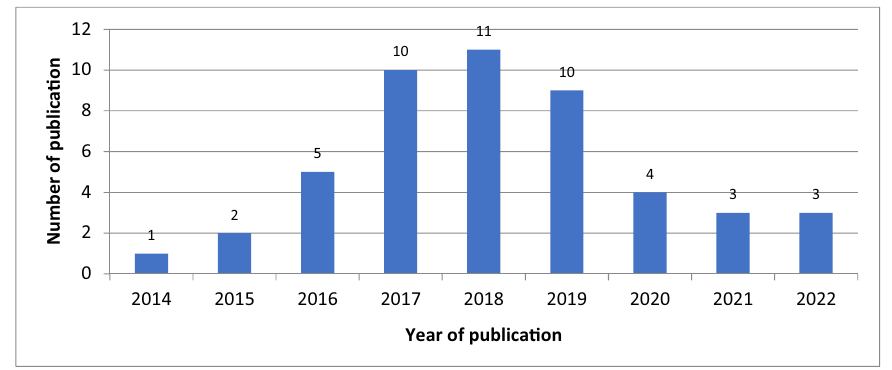
Figure 3: Number of analytical methods reported during 2014 – 2021. Database sources: ScienceDirect, Springer, PubMed, Scopus, Taylor & Francis, and Web of Science.